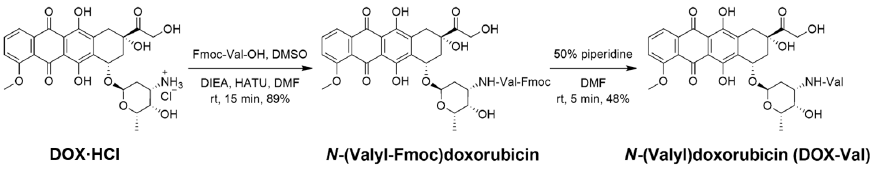
Figure 1 . Synthetic scheme of N -(valyl)doxorubicin (DOX-Val) from doxorubicin hydrochloride (DOX·HCl).